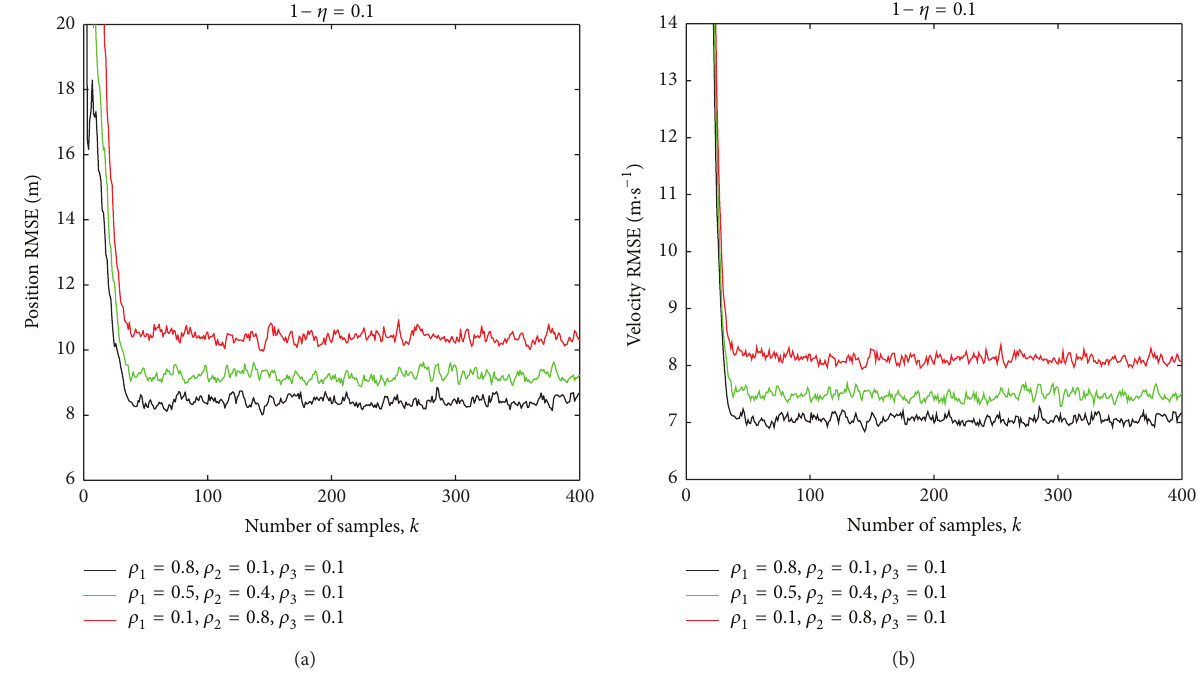
Figure 11: Comparison of the RMSEs for the proposed algorithm with different 𝜌 𝑞 (𝑞 = 1, 2, 3) : (a) position RMSE; (b) velocity RMSE.